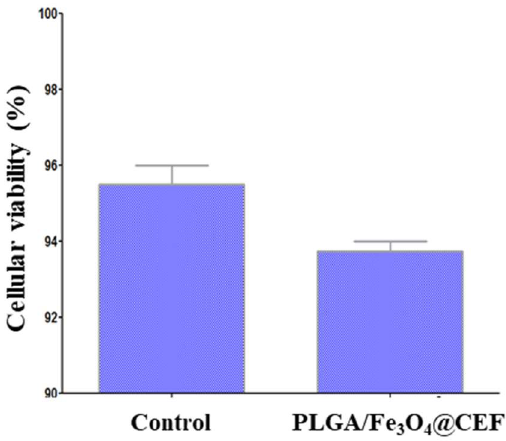
Figure 8. Viability of amniotic fluid-derived stem cells (AFSCs) after 72 h of treatment in the presence of PLGA/Fe 3 O 4 @CEF coating.